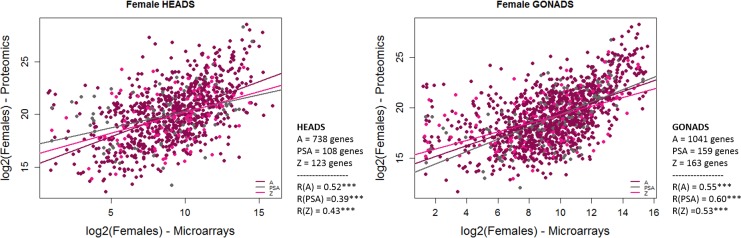
Pearson correlations between gene dosage at the transcript and protein levels in female heads and gonads.A positive correlation (coefficients R) is observed for Z-linked (Z, in light pink), pseudo-autosomal (PSA, in grey) and autosomal genes (A, in dark pink. The level of significance of each correlation is denoted by asterisks: *p-value<0.05, **p-value<0.001, ***p-value<0.0001. No significant difference was found between the correlations obtained for Z-linked and autosomal genes in either tissue (using a Fisher r-to-z transformation).